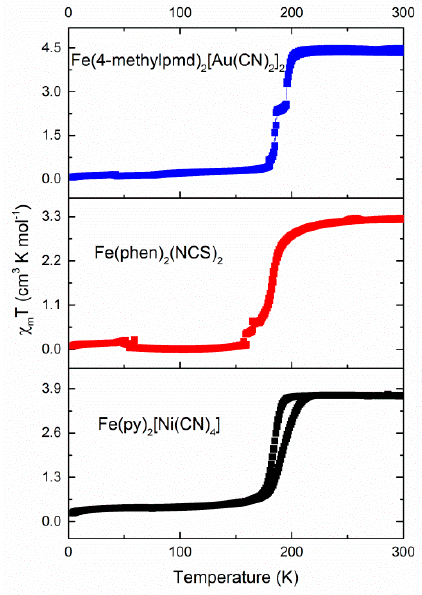
Figure 3. Magnetic susceptibility multiplied by temperature ( χ m T ) showing the LS-to-HS SCO with increasing temperature across T C ’s ranging from 175 K to 205 K.